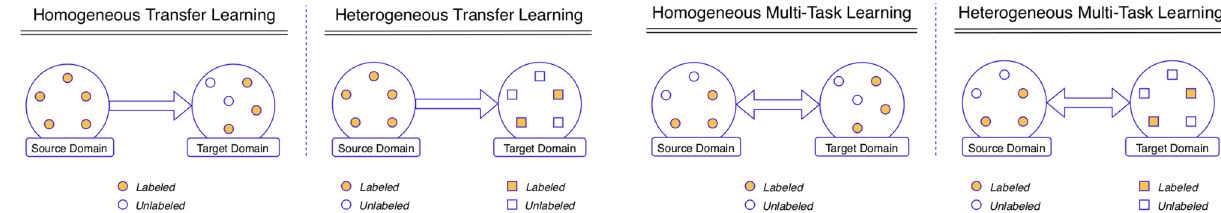
Figure 1. Homogeneous vs Heterogeneous transfer learning settings (left); Homogeneous vs Heterogeneous Multi-Task learning (right). The shape of the instances represents their feature space, while the arrow represents the direction of the transfer of knowledge between the